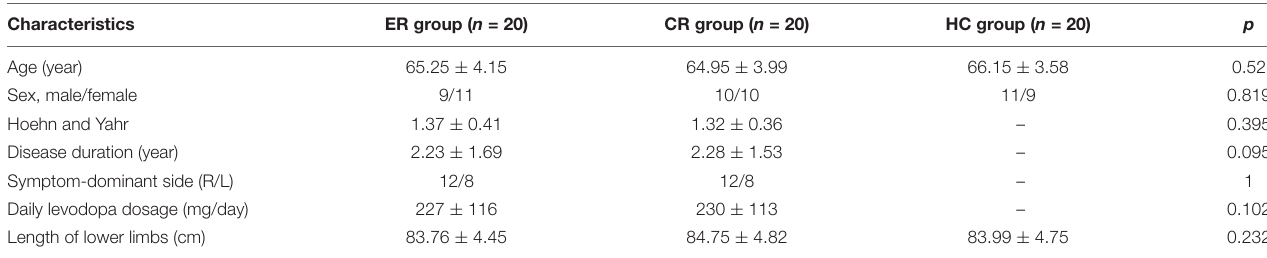
FIGURE 1 | Flowchart illustrating the process for the study. MoCA, montreal cognitive assessment. TABLE 1 | Characteristics of the patients in the study